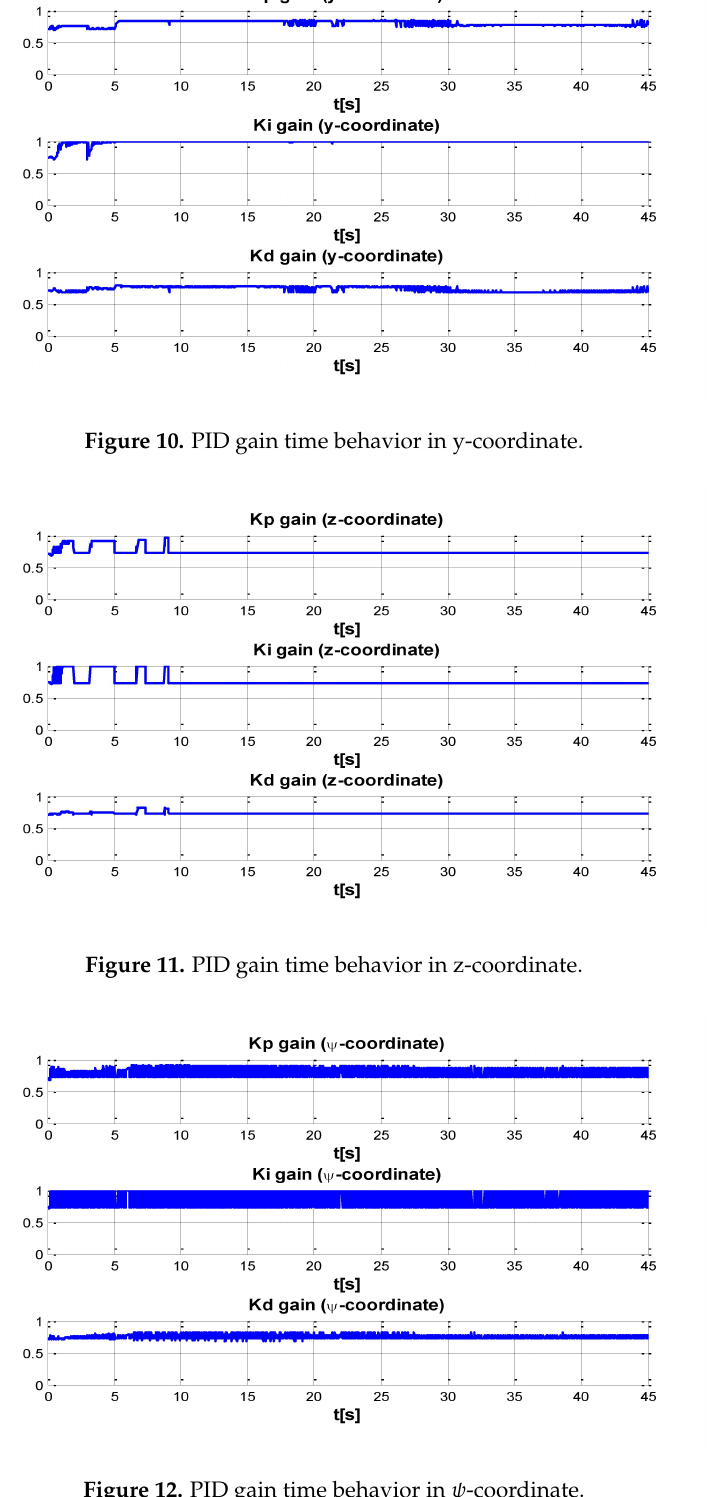
Figure 12. PID gain time behavior in ψ